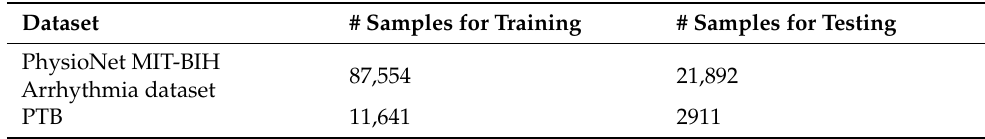
Table 1. Number of training and testing samples in each dataset. Dataset # Samples for